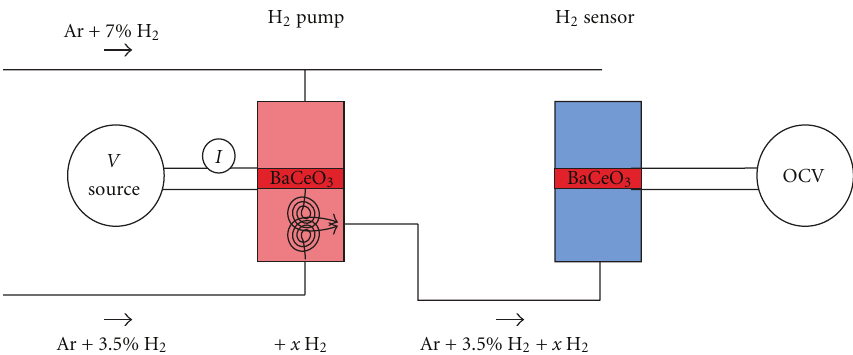
Figure 3: Schematic of experimental setup used for the determination of pumping e ffi ciency.